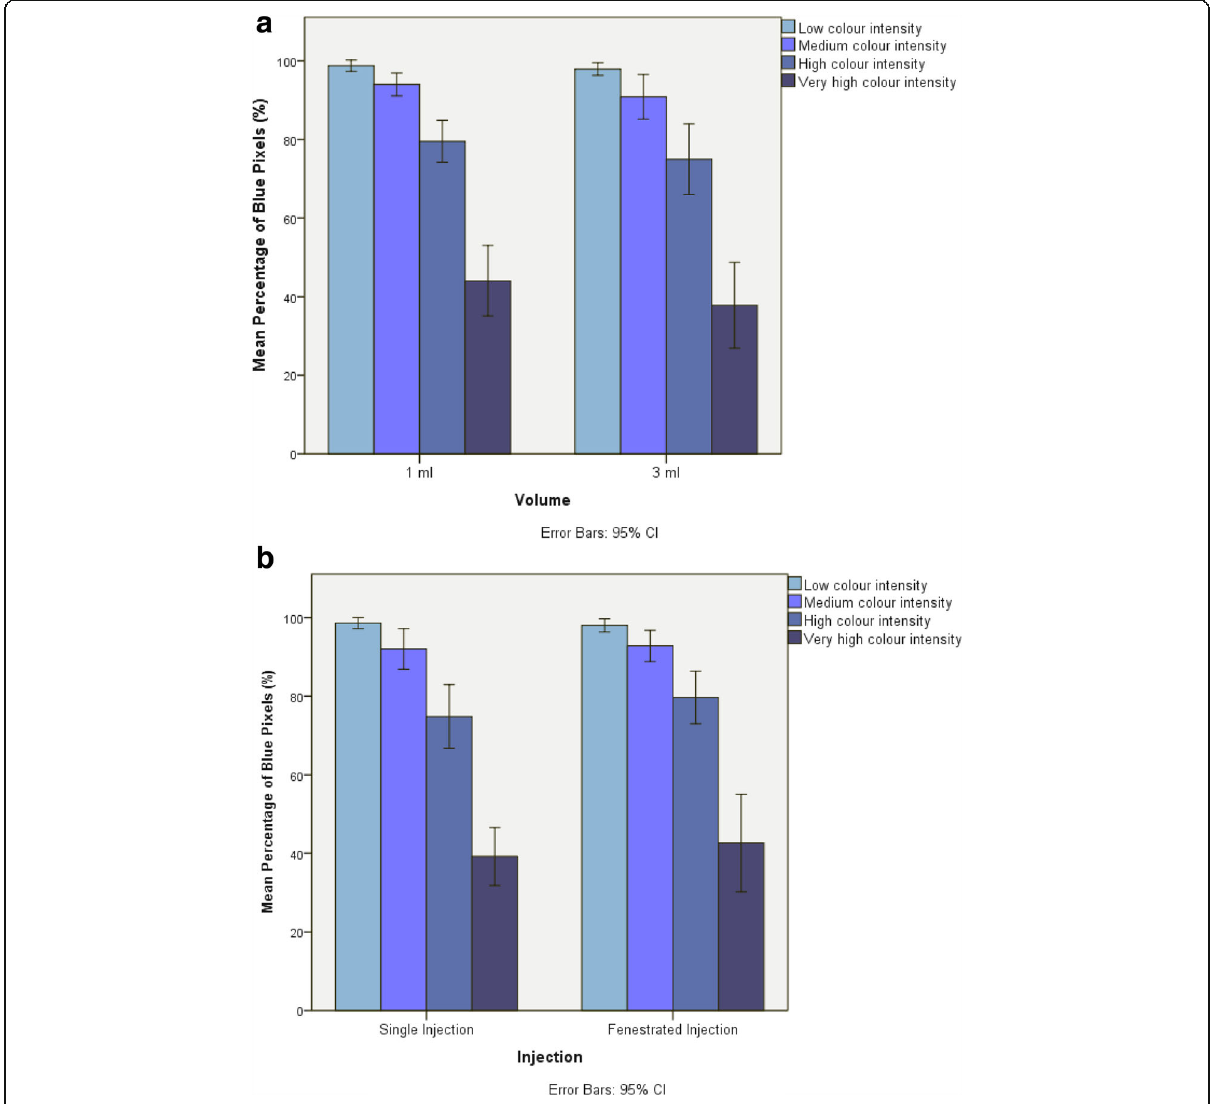
Fig. 4 a Bar chart showing the mean percentage of blue pixels in each of the four colour intensity groups for the 1 ml and 3 ml volume injections. Error Bars = 95% Confidence Intervals. b Bar chart showing the mean percentage of blue pixels in each of the four colour intensity groups for the single injection and fenestrated injection techniques. Error Bars = 95% Confidence